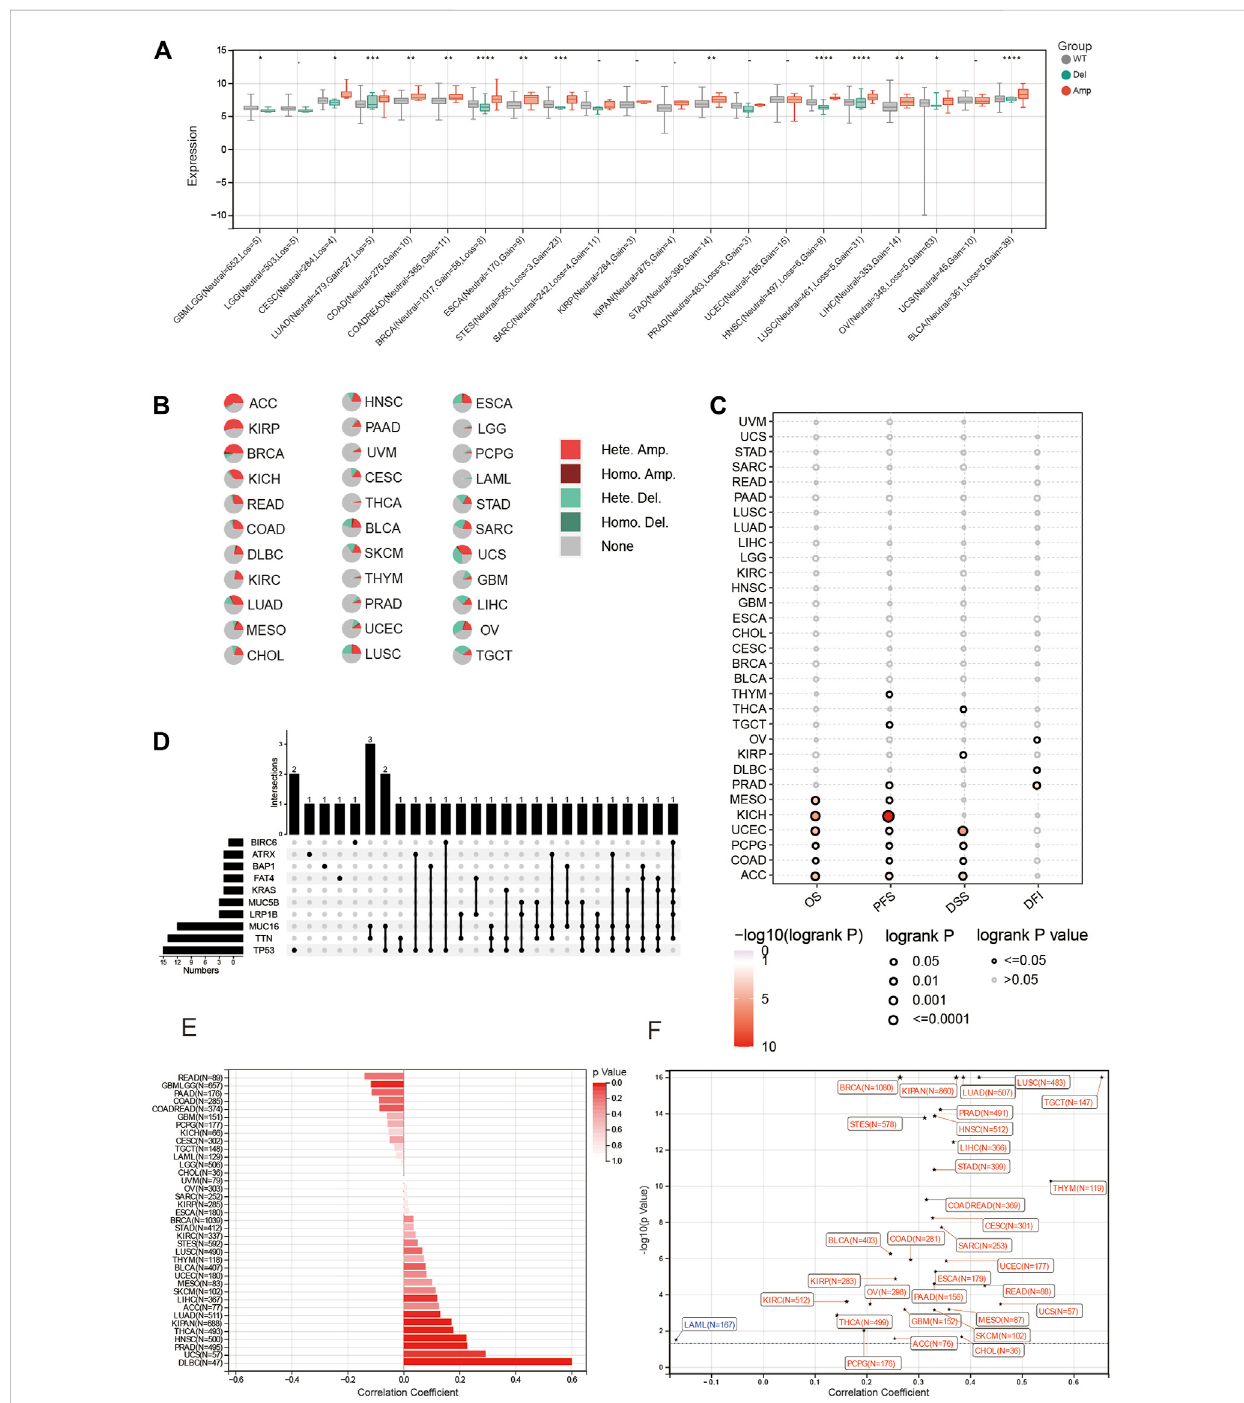
FIGURE 5 Mutation portrayofBOLA2Bacrosscancers. (A) DifferencesofBOLA2BmutationtypeincludingWT,deletion,andampli fi cationindifferentcancers. (B) PiechartofBOLA2Bampli fi cationincancers. (C) Copynumbervariation(CNV)ofBOLA2BindicationonthePrognosisIndex. (D) Upsetplotofpossible genes mutation affected BOLA2B expression. (E) Bar chart of microsatellite instability (MSI) relationship with BOLA2B. (F) Tumor stemness of various cancers in fl uenced by BOLA2B